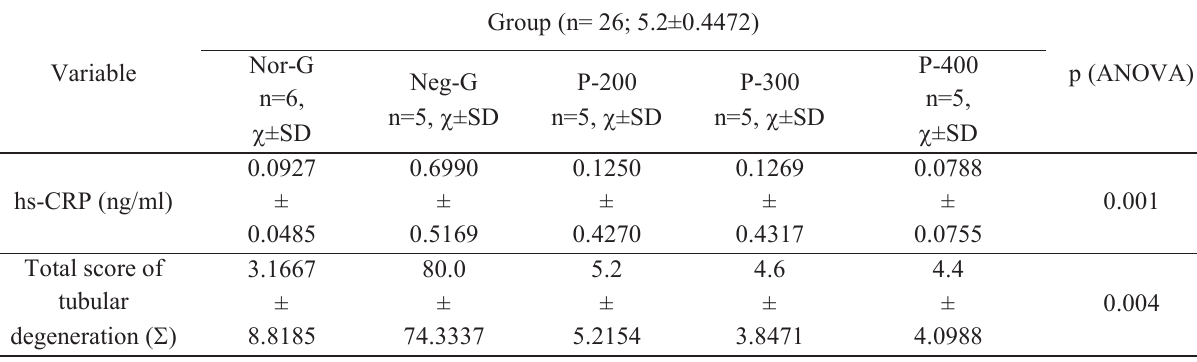
Tabel 1. Mean level of hs-CRP and renal tubular degeneration